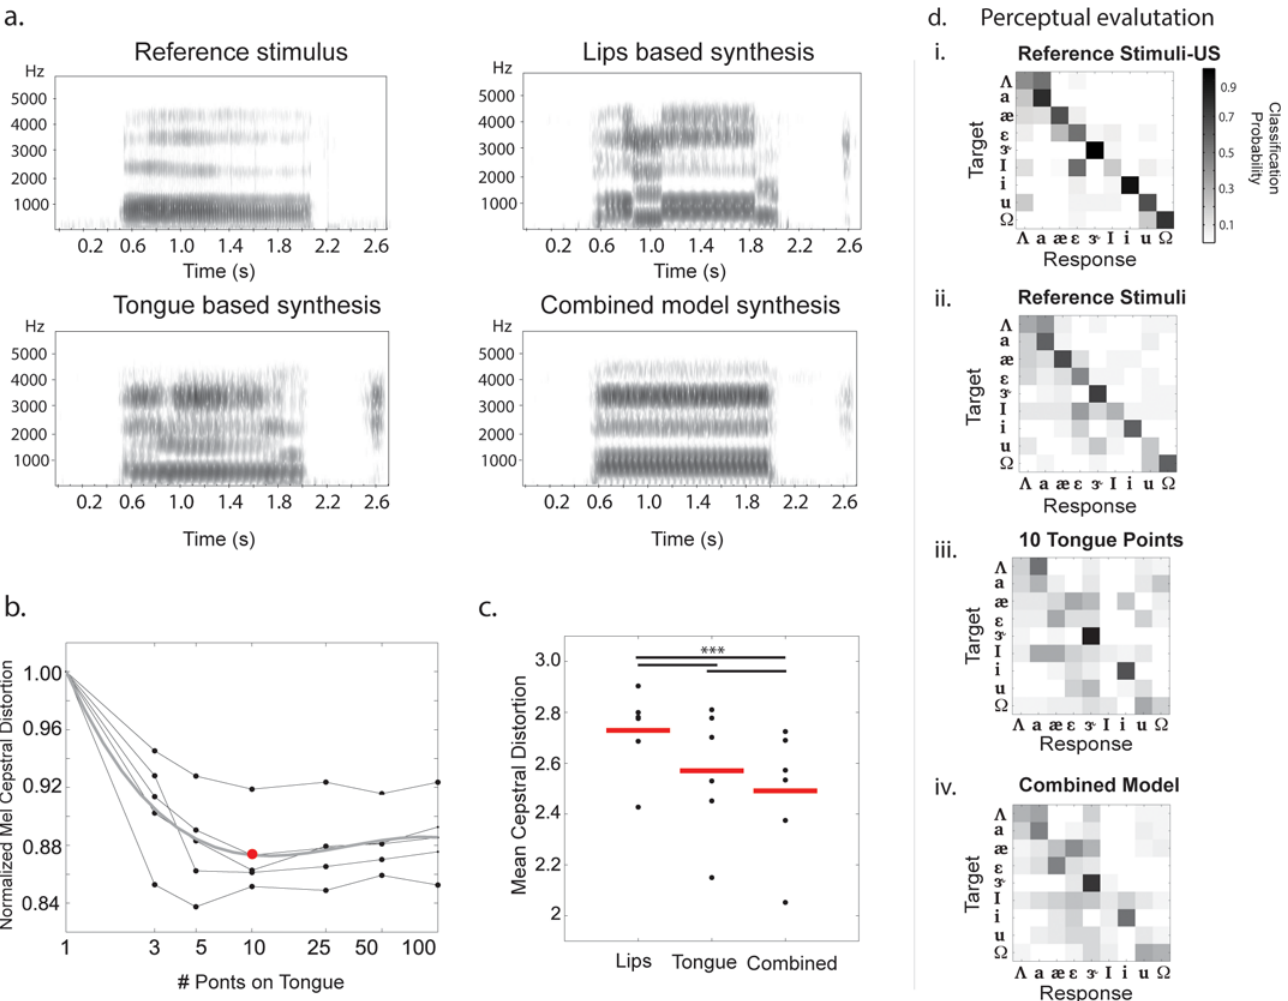
Fig 6. Synthesis of speech from articulator kinematics. a ) Examples of reference and synthesized stimuli using various articulatory feature sets as identified for articulation of a phoneme / ɑ / by one speaker. b) Error on synthesized acoustics, measured as a mean cepstral distortion measure with increasing number of tongue points. Each subject is one black line, overlaid with a grey trend for average across subjects. Red dot at 10 points is selected as the optimal set of tongue points. c) Prediction error with different sets of articulators used for synthesis, each subject is one dot and the mean across subjects is marked with the red line segment. d) Reference natural stimuli as perceived by listeners based in the United States (i) and Turkers globally (ii) Stimuli synthesized using 10 tongue points (iii) and using both tongue and lip kinematics